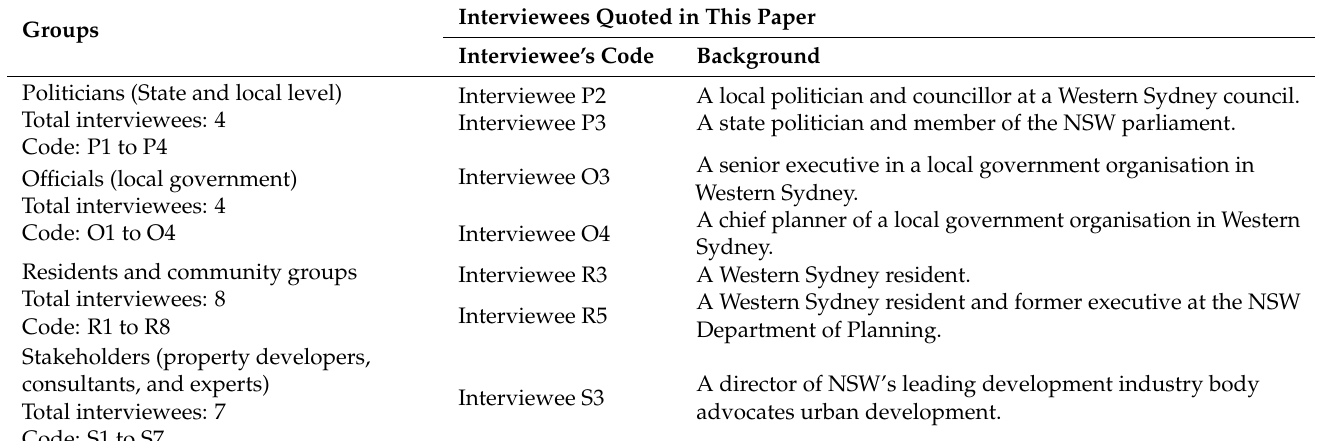
Table 1. Summary of interviewees associated with this